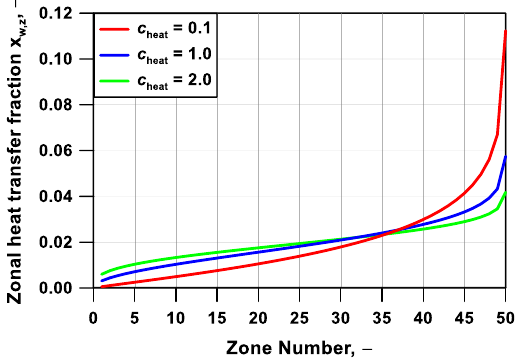
Figure 6. Tested profiles for the heat transfer fraction per unit mass versus the cumulative mass fraction.